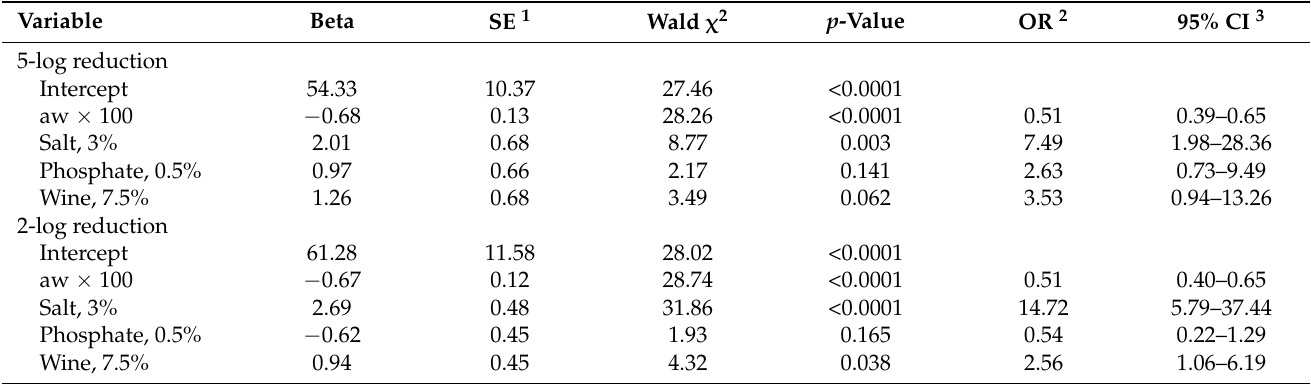
Table 6. The logistic regression model results for achieving a 5- and 2-log reduction in the Salmonella population in a cured sausage, considering the aw, salt level, phosphates, and wine as